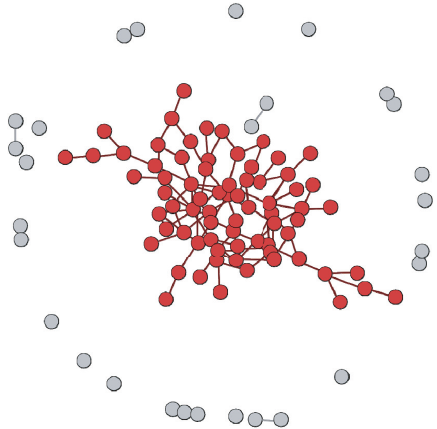
Figure 4: Stable state of alliance development.